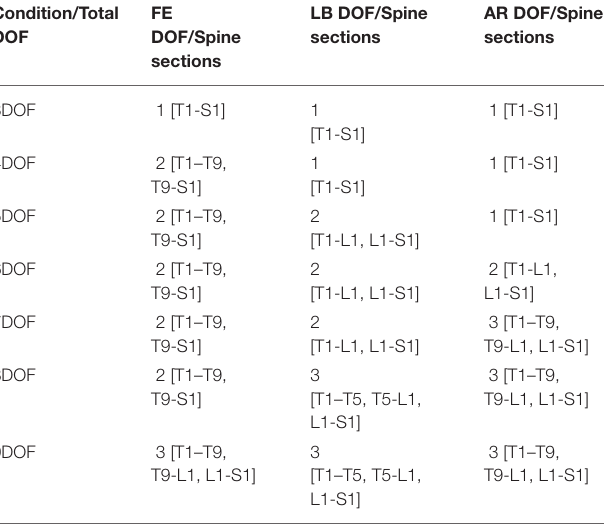
TABLE 3 | Summary of kinematic constraint conditions tested, indicating the total spine DOF and DOF in each rotational direction, plus the spine sections for each DOF and rotational